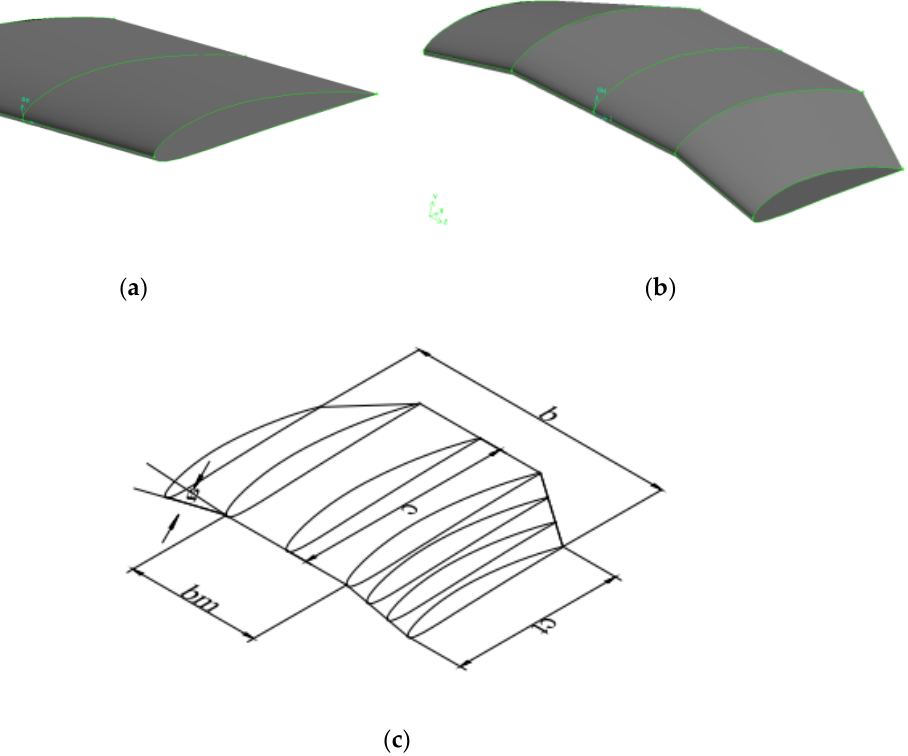
Figure 1. ( a ) Rectangular wing, ( b ) compound wing, and ( c ) compound wing explanation. Table 1. Principle dimensions of the compound and rectangular wings.